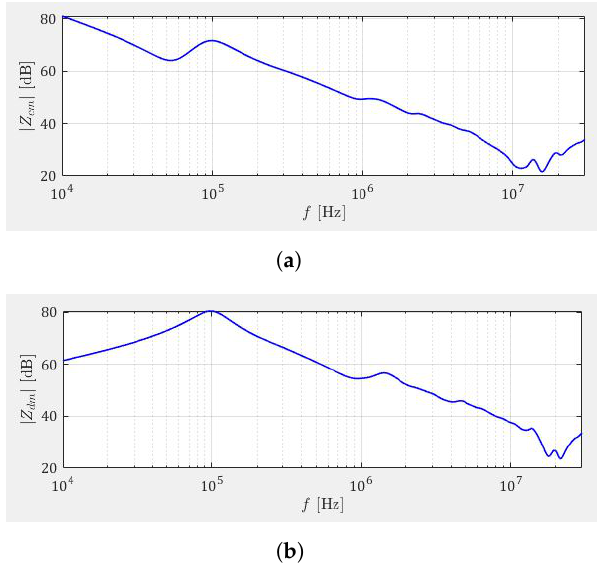
Figure 19. Measured impedances: ( a ) common mode, ( b ) differential mode.